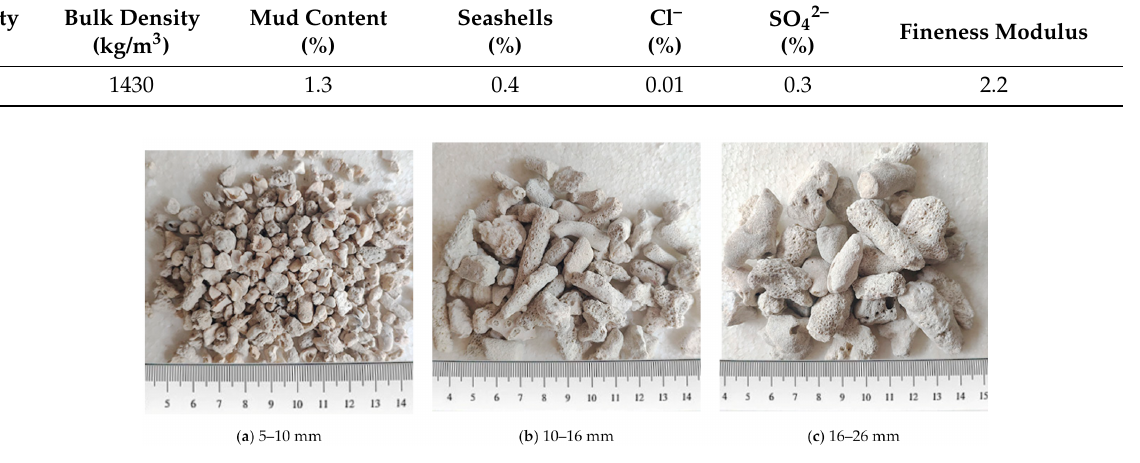
Figure 1. Coral aggregates of different sizes. Table 4. Physical properties of coral coarse aggregate.